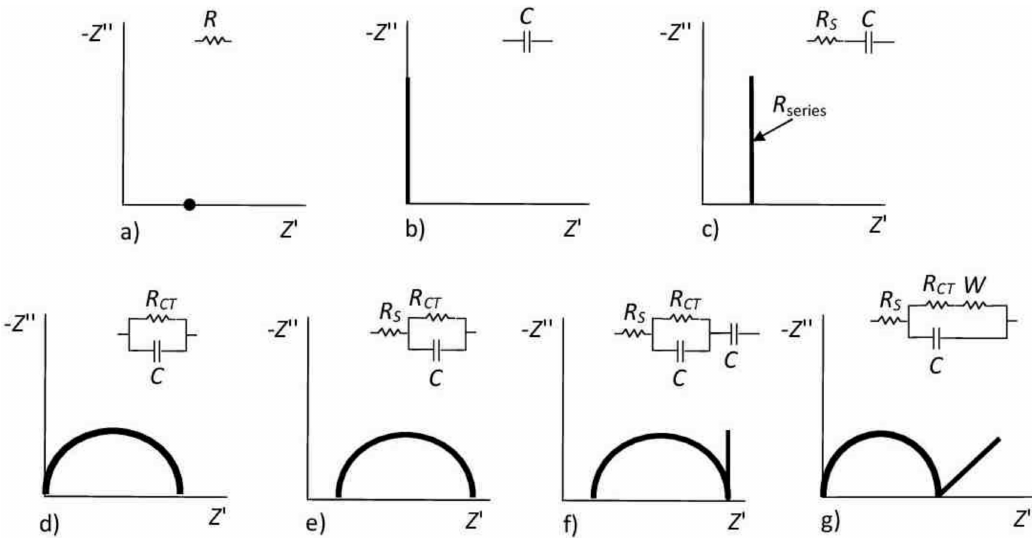
Figure 4. Typical Nyquist plots for various electrical circuits, moving from those that are the most simple to the more common. Upper row: ( a ) pure resistor ( R , only real part of impedance); ( b ) pure capacitor ( C , only imaginary part of impedance); ( c ) R and C in series connection. Lower row: ( d ) R and C in parallel connection; ( e ) R and C in parallel connection and in series with a solution resistance ( R S ), where R CT denotes the charge transfer resistance of the interface; ( f ) the same circuit with additional in-series capacitance and ( g ) Randles–Ershler equivalent circuit, most commonly used for fitting impedimetric biosensor data, where W stands for Warburg element (di ff usion parameter for low frequencies). Adapted from ref. [54], Copyright (2014), with permission from Elsevier and reprinted from ref. [51], Copyright 2019, with permission from John Wiley and